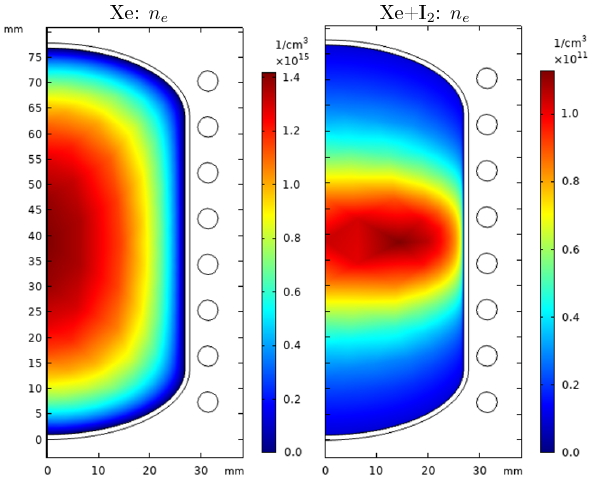
Figure 2. Comparison of the electron density distribution at 400W input power with 3MHz and an initial pressure of 190Pa. Left : Xe discharge. Right : I 2